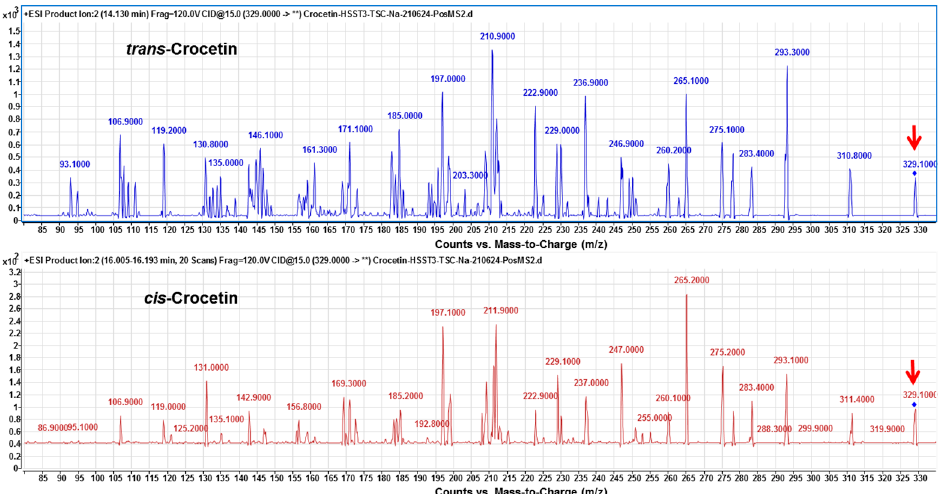
Figure 8. The MS spectra of trans - and cis -crocetin from HPLC-ESI (+)-MS/MS analysis. Fragmenta- tions from collision- induced dissociation of molecular ion at m / z 329 (as indicated by the red arrow) were produced in the positive ion mode of electrospray ionization. The MS fragmentations of trans - and cis -crocetin did not illustrate a significant difference between each